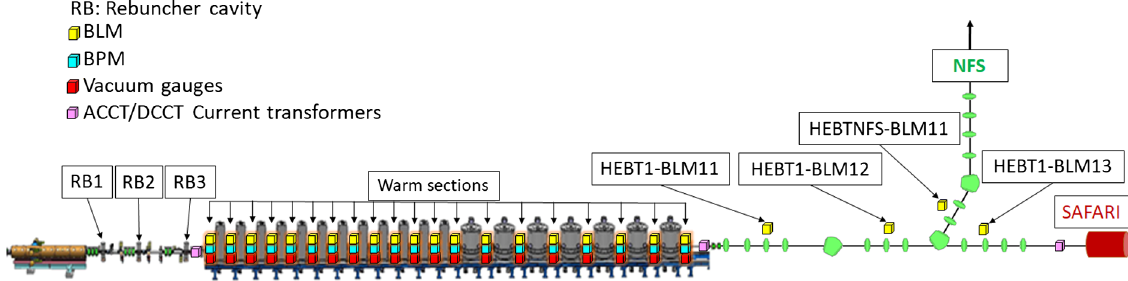
FIG. 2. Beam diagnostics in the SPIRAL2 SC linac used for the beam power ramp-up.